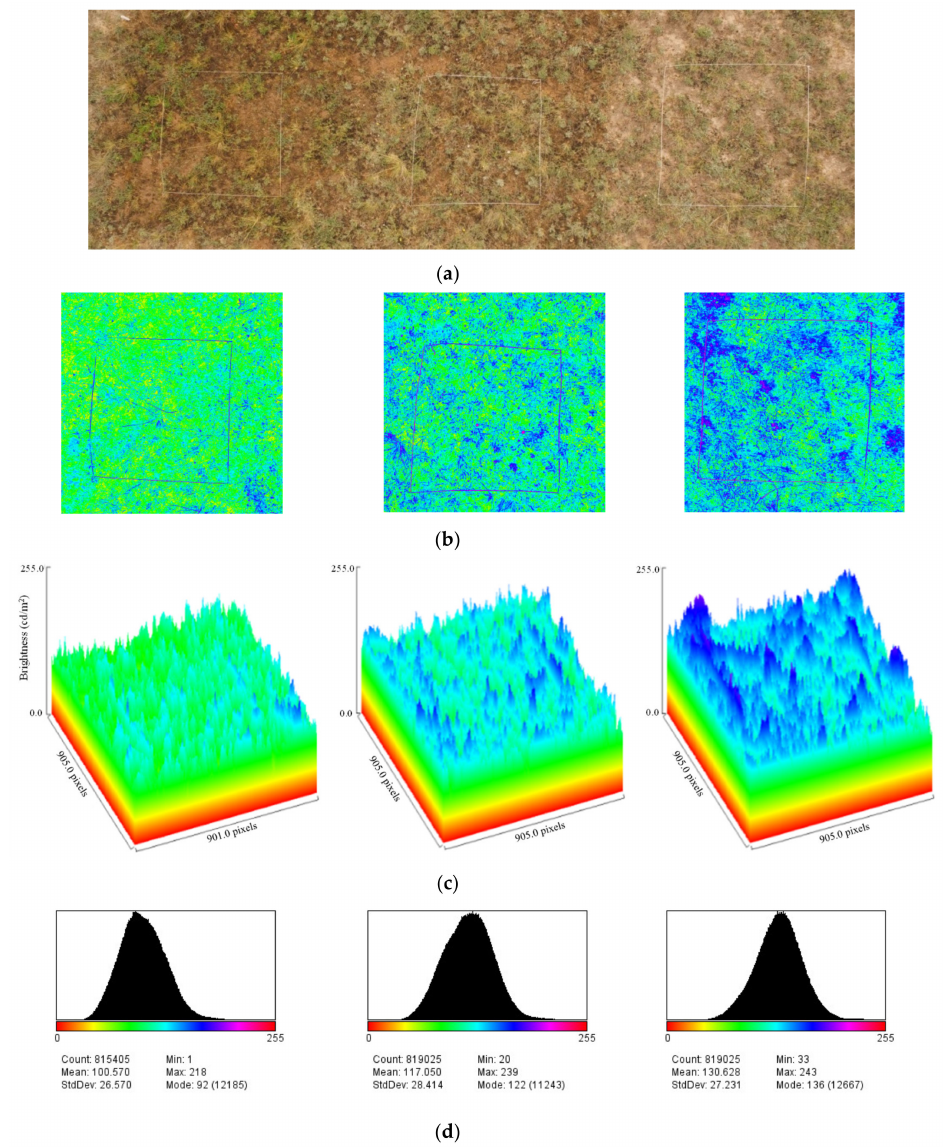
Figure 4. Processing of aerial visible images; ( a ) UAV visible image, ( b ) Eight-bit grayscale images with spectral filter, ( c ) 3D surface plot, ( d )